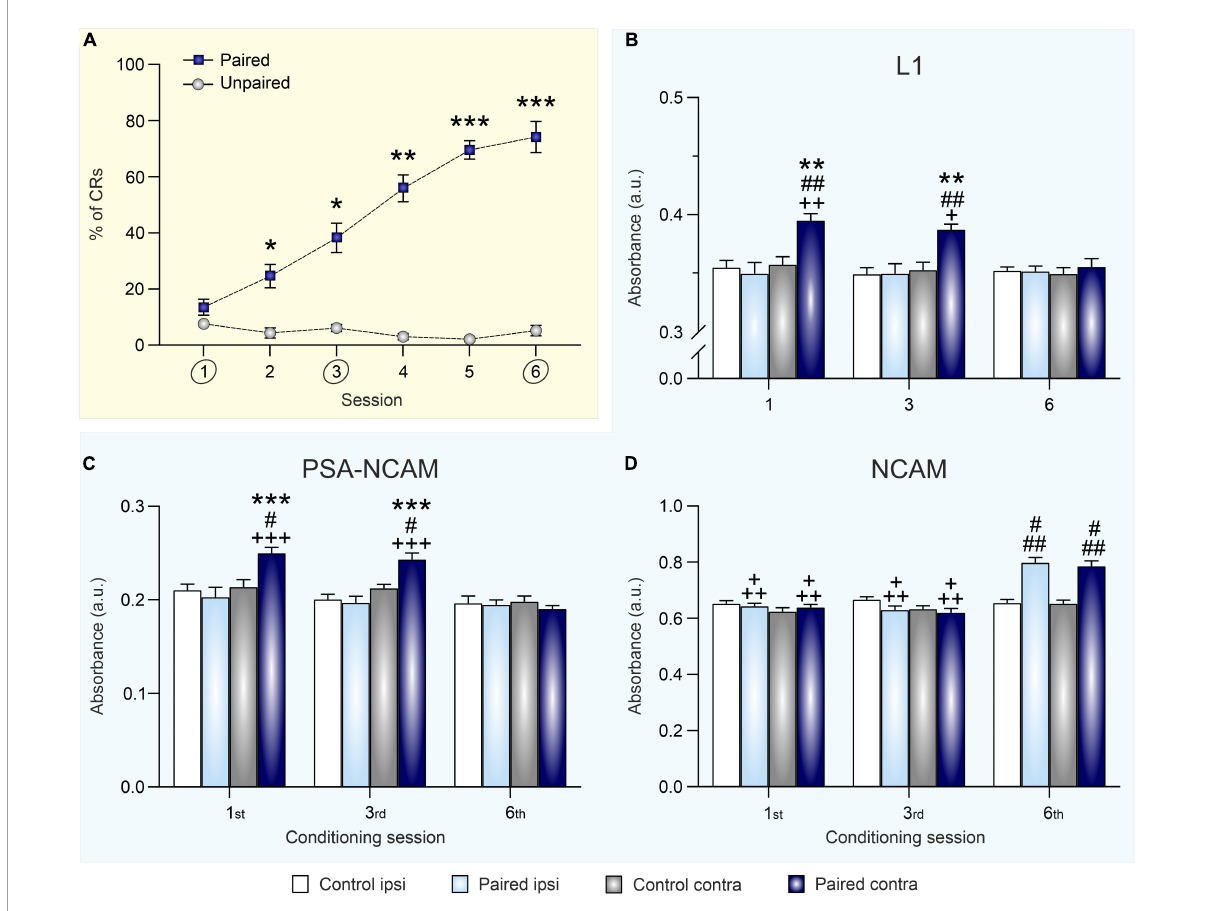
FIGURE2 Eyeblink conditioning acquisition modulates synaptic expression of L1, PSA-NCAM, and NCAM in the hippocampus. (A) Percentage of conditioned eyelid responses [conditioned responses (CRs)] across six conditioning sessions. Data is expressed as mean ± SEM of animals sacrificed at the end of the sixth session. * p < 0.05, ** p < 0.01, *** p < 0.001 vs. unpaired. (B–D) Optical density measurements of L1 (B) , PSA-NCAM (C) , and NCAM (D) expression, after the 1st, 3rd, and 6th training sessions, in hippocampal synaptosomes obtained from right (ipsilateral to CS and US presentation) and left (contralateral) hippocampi of conditioned and control (merged from unpaired and context groups) animals. Data is expressed as mean ± SEM for each session (1st: paired group n = 8 and control group n = 10; 3rd: paired group n = 9 and control group n = 11; 6th: paired group n = 9, and control group n = 10). a.u., arbitrary units. ** p < 0.01, *** p < 0.001 vs. ipsi; # p < 0.05, ## p < 0.01 vs. control; + p < 0.05, ++ p < 0.01, +++ p < 0.001 vs. session